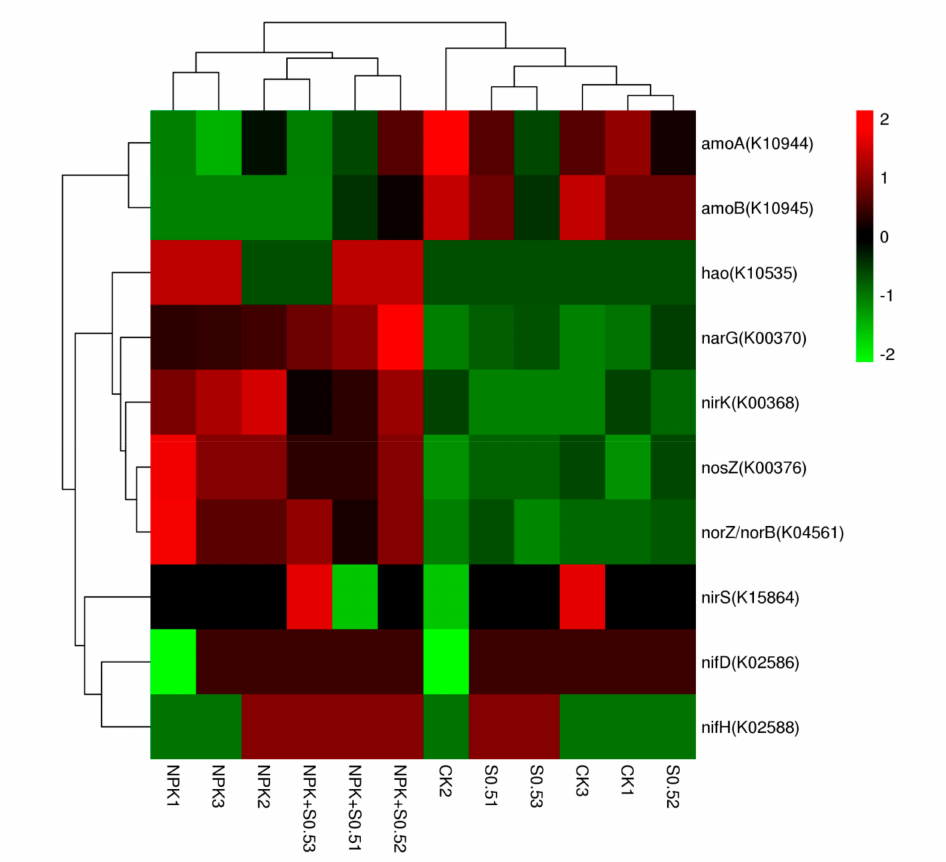
Figure 5. Heatmap of soil nitrogen cycle microbiome abundance genes with di ff erent fertilizer